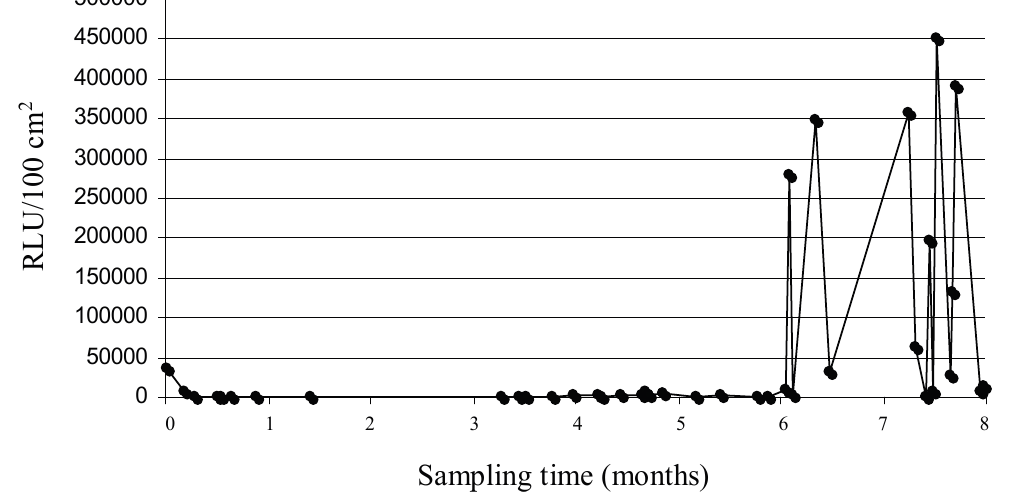
Figure 1. Eight-month RLU measurements trend for raw meat chopping board RLU Relative Light Units.